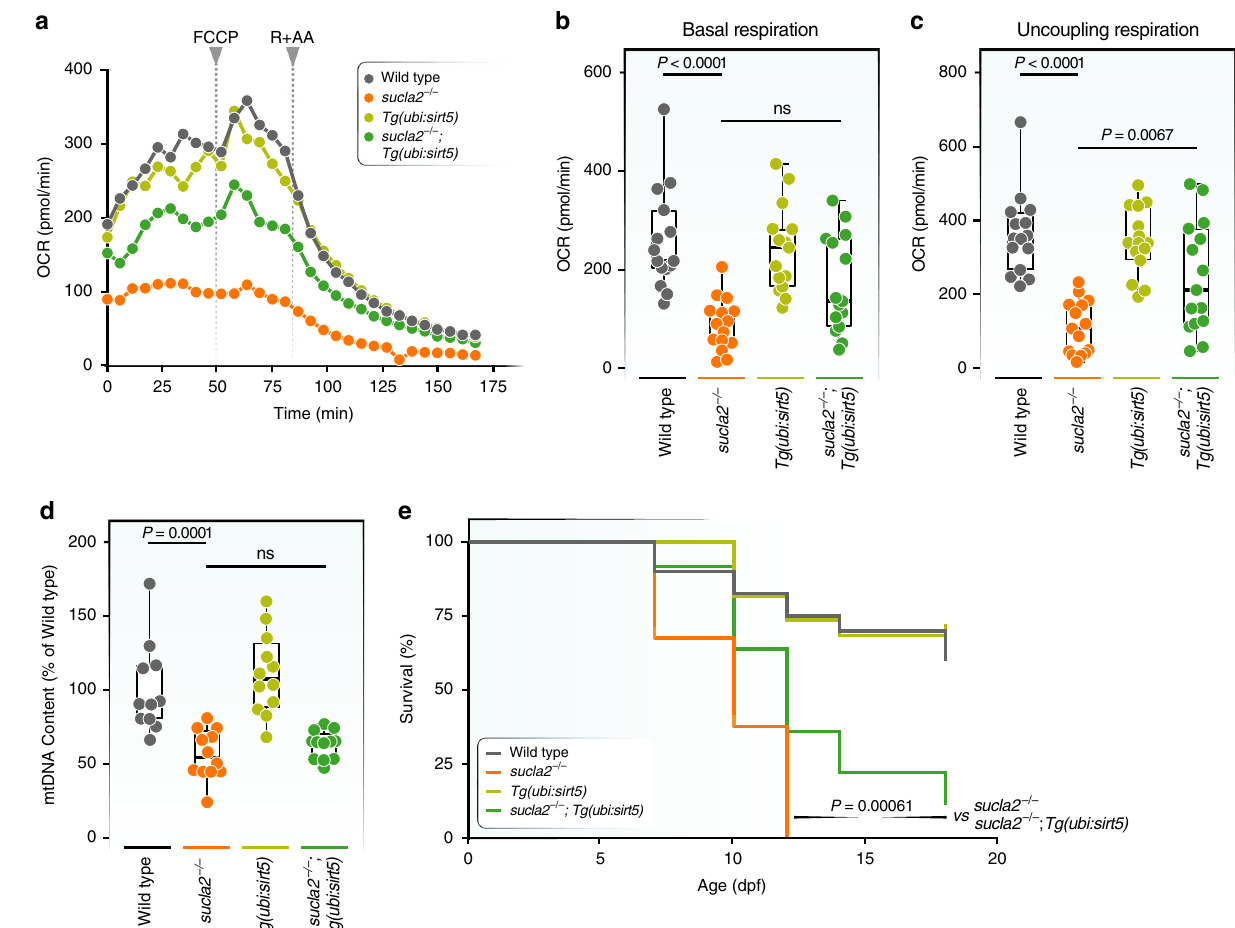
Fig. 5 Sirt5 restores oxidative metabolism and improves survival of sucla2 − / − zebra fi sh. a Oxygen consumption rate (OCR) in sucla2 − / − and control zebra fi sh larvae with or without sirt5 overexpression ( n = 15 per group, 10dpf), before and after the addition of inhibitors of mitochondrial respiration. The uncoupler FCCP is added to stimulate maximal OCR. Rotenone and antimycin A (R + A) determine non-mitochondrial respiration. b Basal OCR calculating the average of the three last points before addition of FCCP. c maximal OCR. d qPCR analysis of mitochondrial DNA content in sucla2 − / − and control zebra fi sh larvae with or without sirt5 overexpression ( n = 12 per group, 10dpf). e Survival of sucla2 − / − and control zebra fi sh larvae with or without sirt5 overexpression in standard (fed) conditions ( sucla2 + / + , n = 40; sucla2 − / − , n = 37; sucla2 + / + ;Tg(ubi:sirt5) , n = 38; sucla2 − / − ; Tg(ubi:sirt5) , n = 36). Data are pooled from two independent experiments. p -Value for median survival of wild type vs sucla2 − / − <0.0001, p-value sucla2 − / − vs sucla2 − / − ; Tg(ubi:sirt5) = 0.00061. Pairwise comparison using log-rank test. p -Value adjustment was performed by Bonferroni correction. The boxplots show the median, the fi rst to third quartile, and minima and maxima). n.s., not signi fi cant. mtDNA = mitochondrial DNA; dpf = days post fertilization. Source data are provided as a Source Data fi